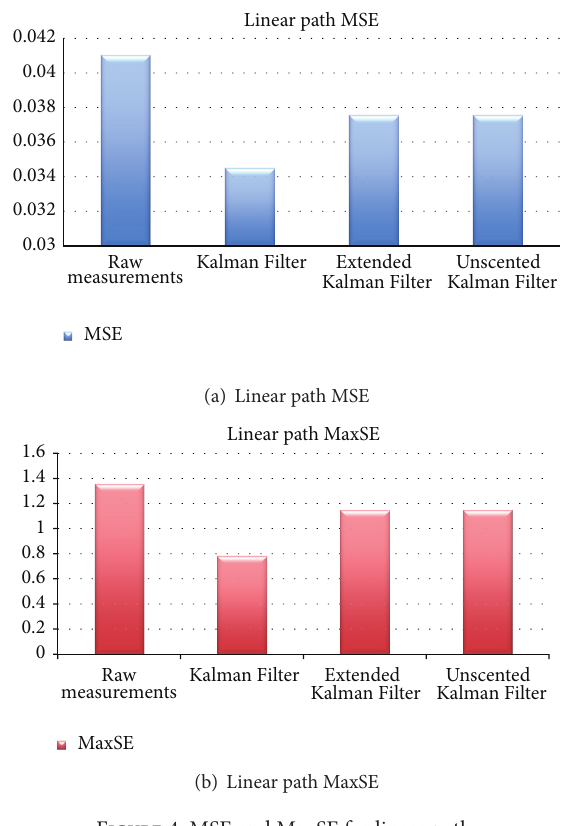
Figure 4: MSE and MaxSE for linear path. Table 4: MSE and MaxSE for one and five tags using Kalman Filter. One tag Five